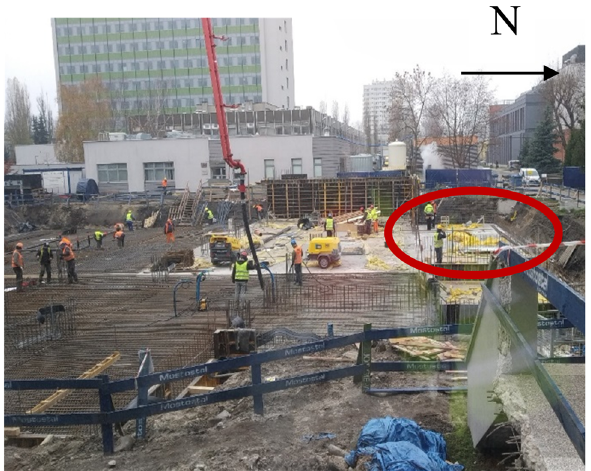
Figure 3: An image showing the construction site marking the shielding location during the concrete casting. Own source,